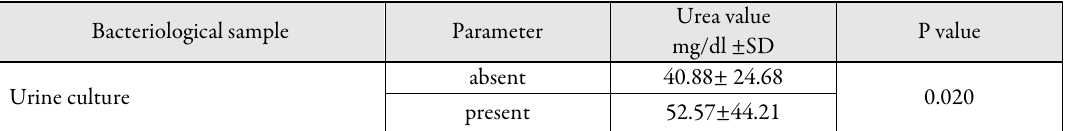
Table 3. The correlation between the urine culture and the average values of blood uremia, at admission